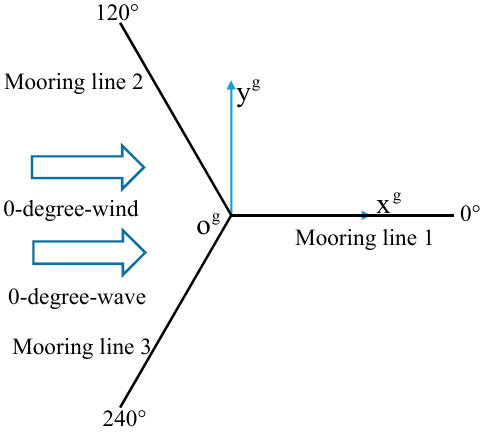
Figure 4. Arrangement of the mooring system.